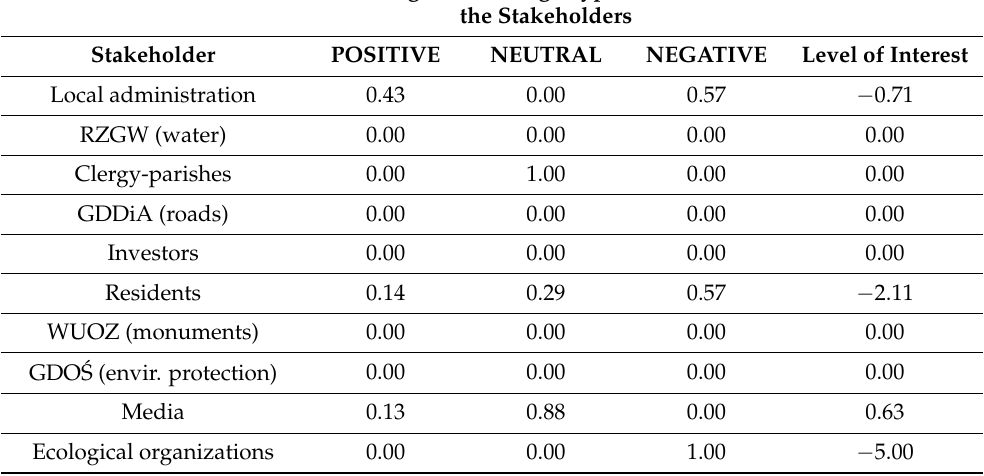
Table 5. The results of the calculations of the level of interest of the local stakeholders in the Cyc ó w LW Bogdanka mining